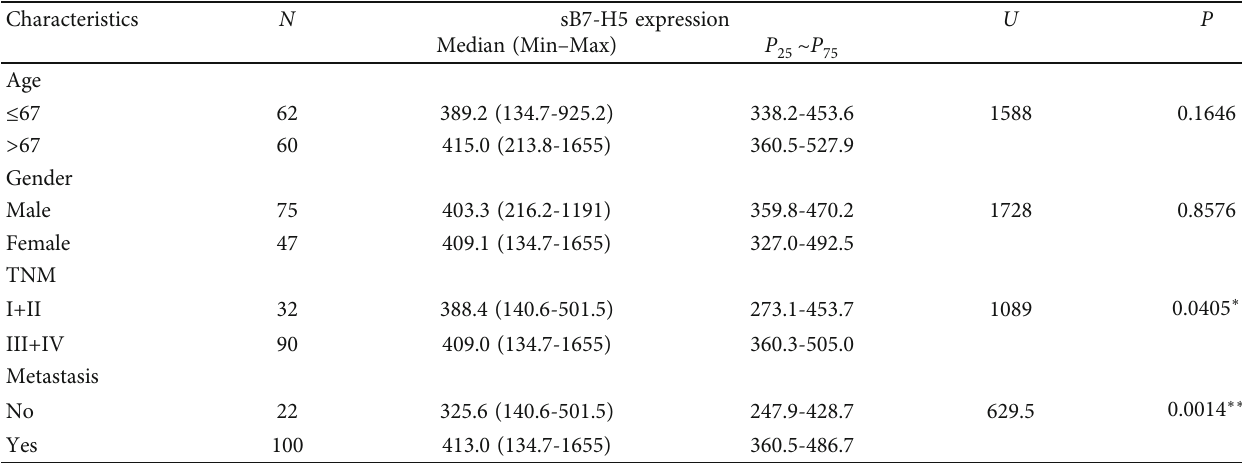
Table 3: The relationship between the levels of sB7-H5 in sera of patients with LC and clinicopathological characteristics.